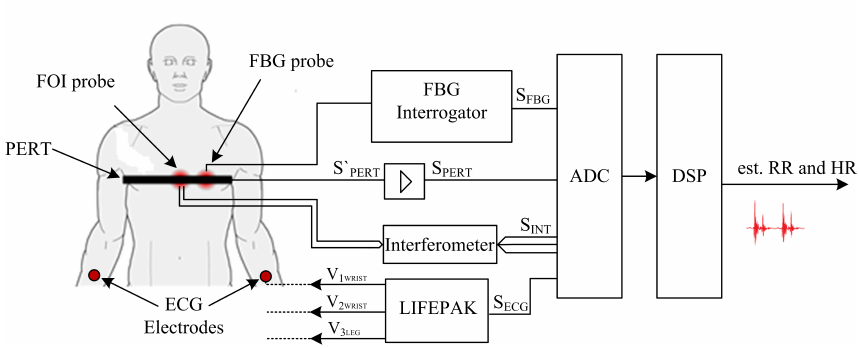
Figure 7. Basic schematic diagram of the